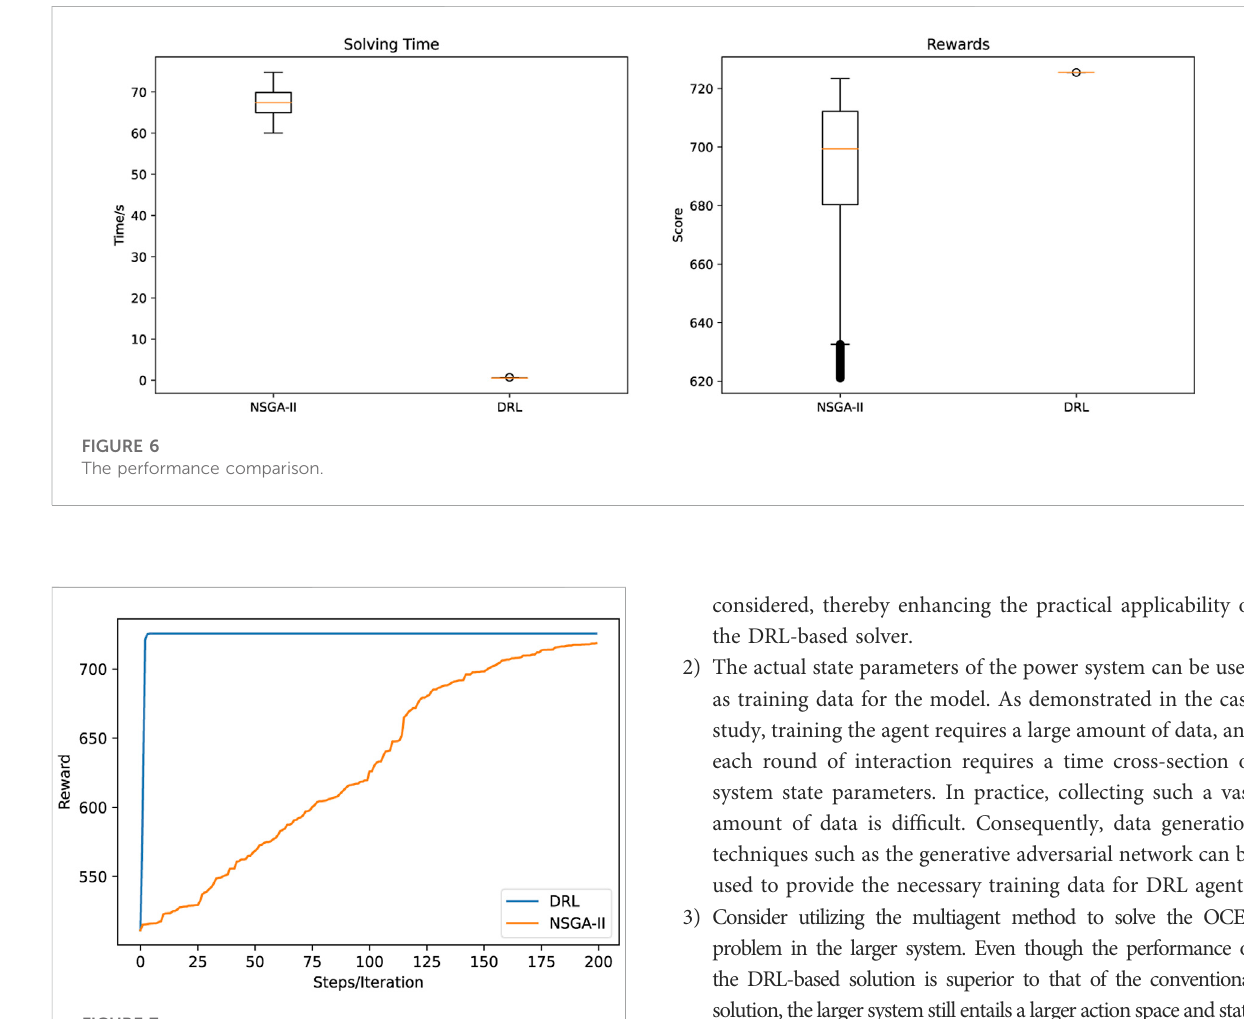
FIGURE 7 The comparison of solution